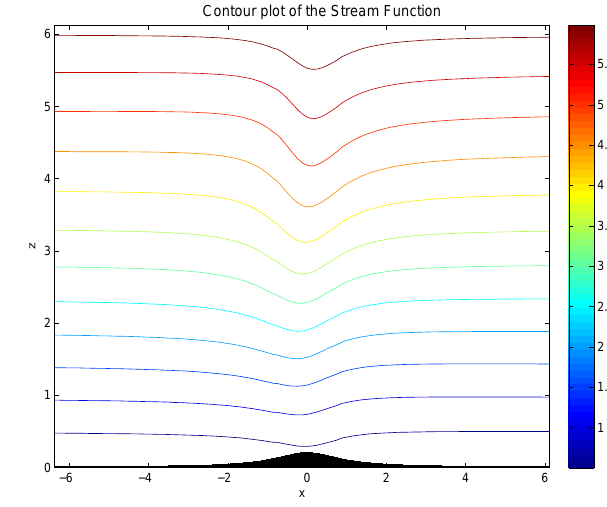
Fig. 2. Same as Fig. 1 with δ = 0 .